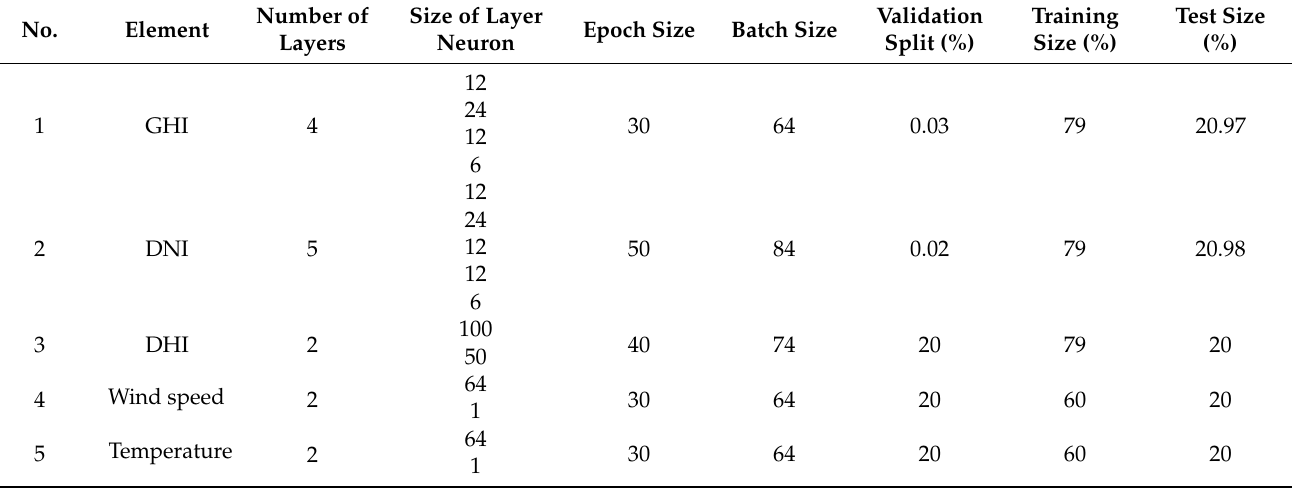
Table 1. Number of layers and the parameter settings of the BI-LSTM